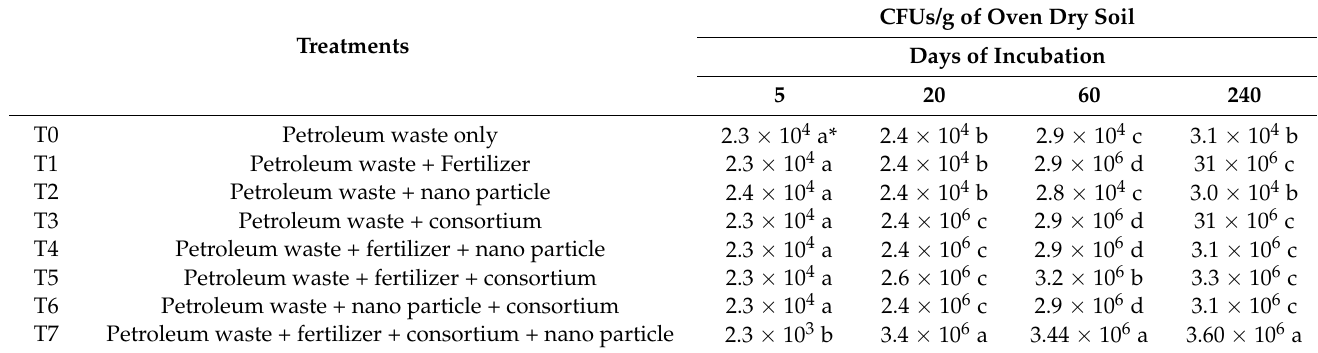
Table 3. The difference in the colony forming units (CFUs/g of over dry soil) between petroleum waste (T0) and other treated petroleum waste soils (T1–T7) at 5, 20, 60, and 240 days of incubation.